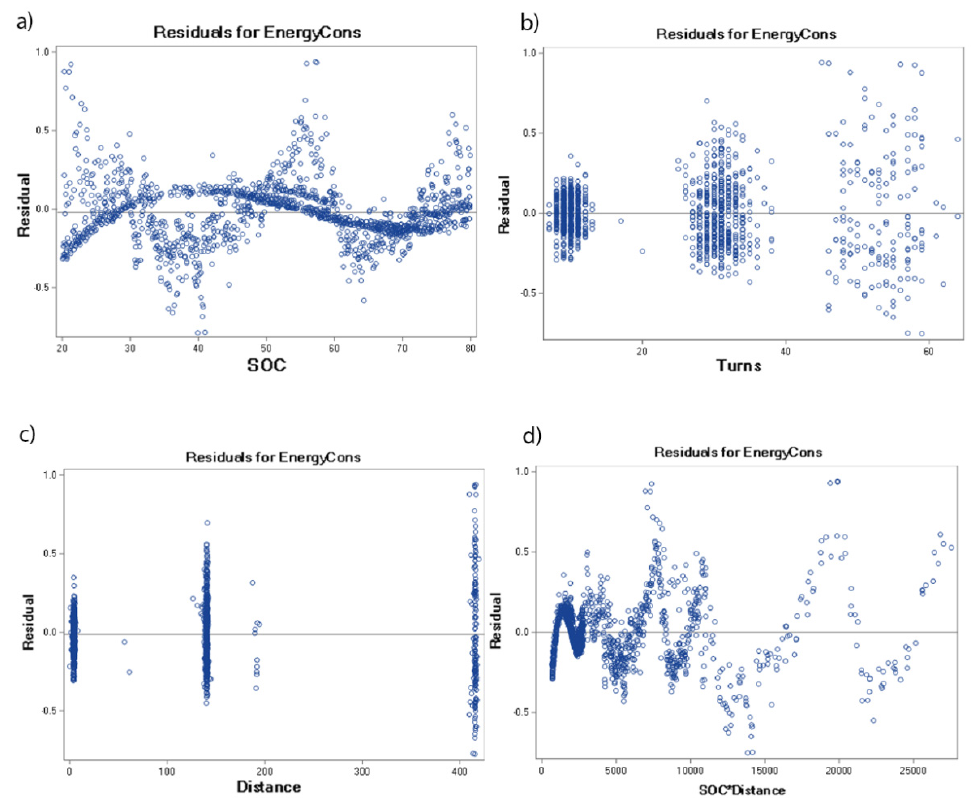
Figure 5. Outlier and Leverage diagnostic for predicted variable of the tested batteries: ( a ) battery from 2018, ( b ) battery from 2020.